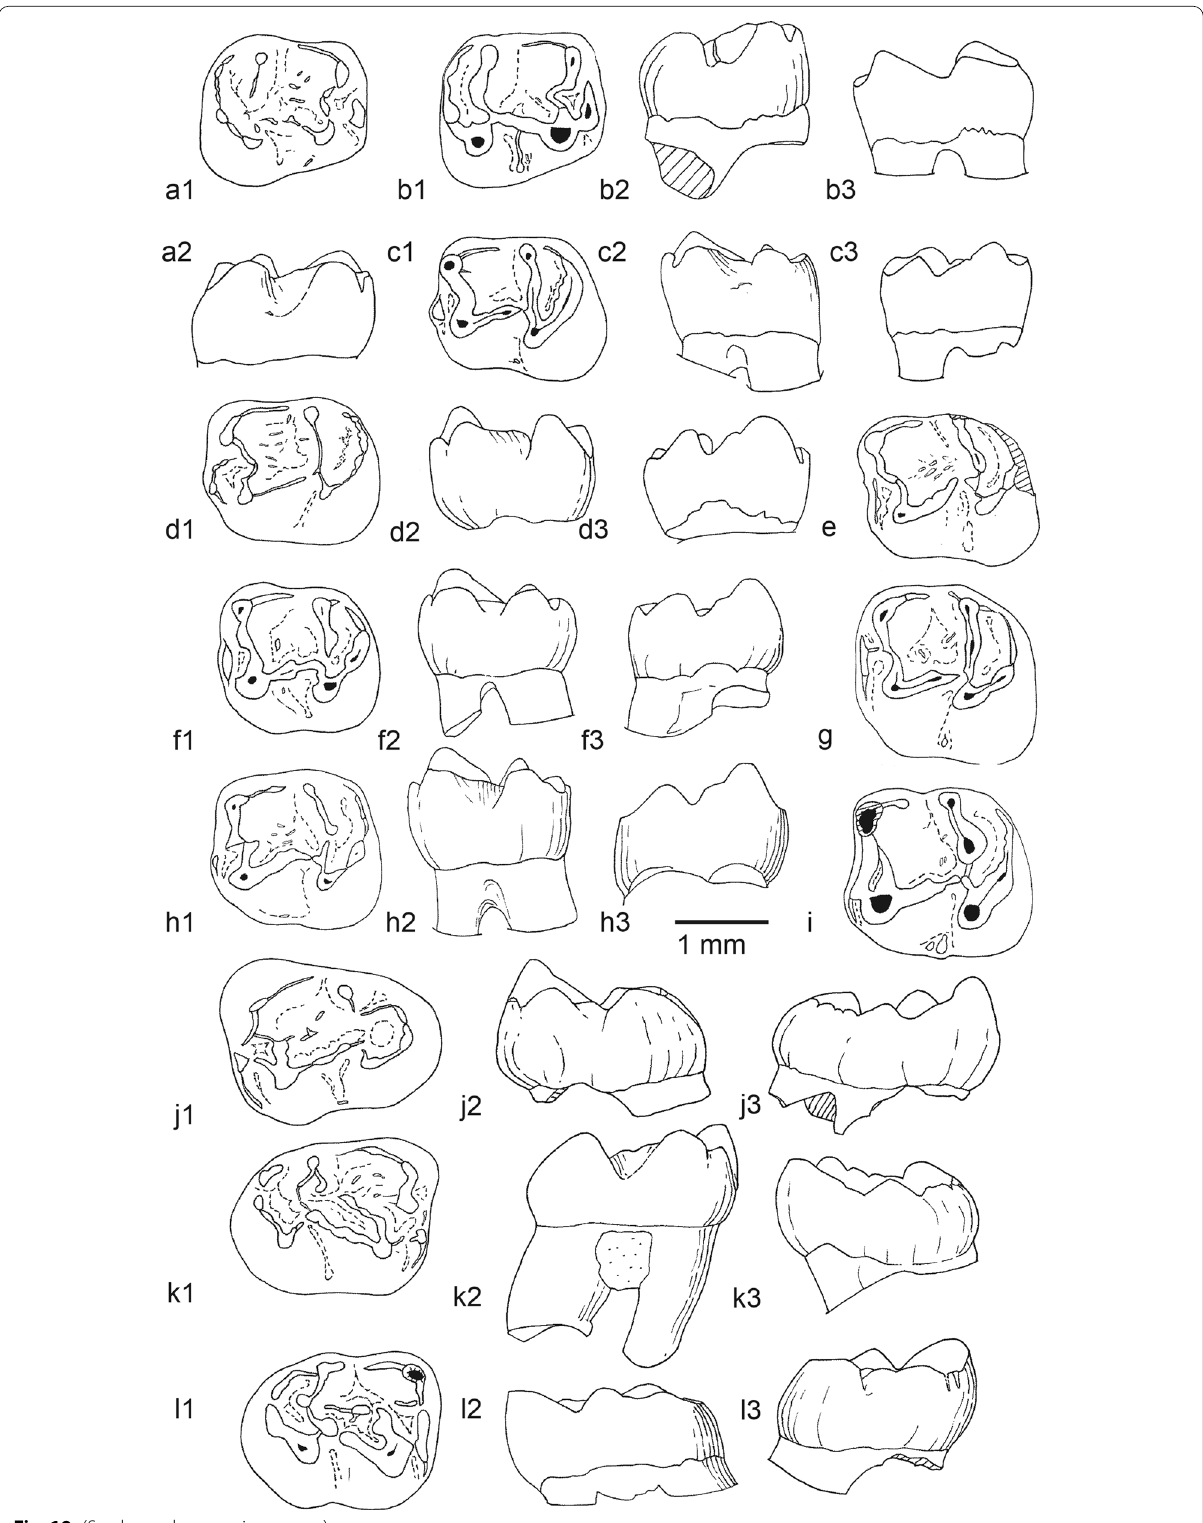
Fig. 19 (See legend on previous